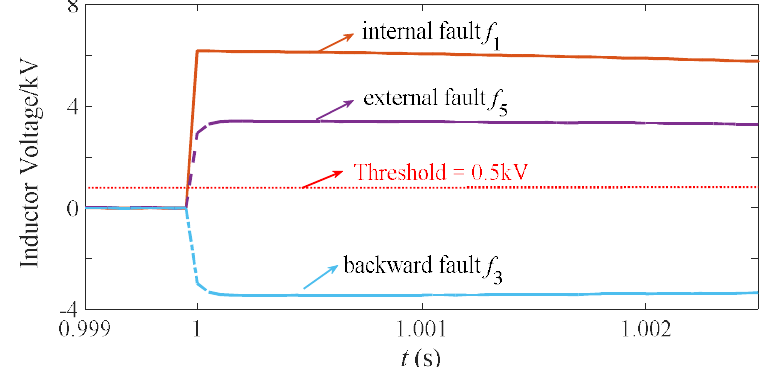
Figure 13. The DC inductor voltage of pole-to-pole faults at different distances.